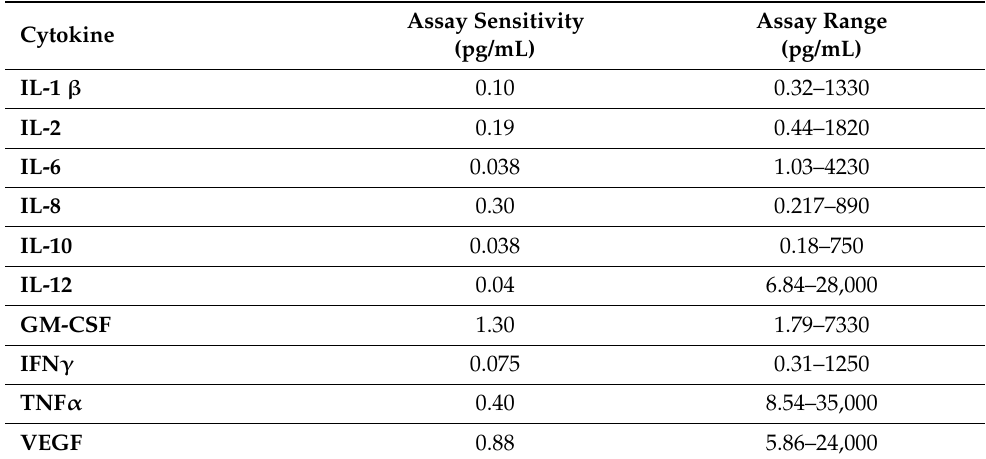
Table 2. Sensitivity and range of the individual cytokine standard curves used in the multiplex